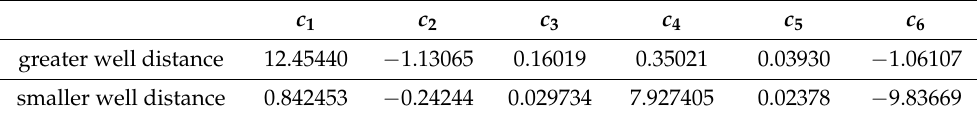
Table 6. Coefficients for storability correlation for the smaller and greater distances given in Figure 8.